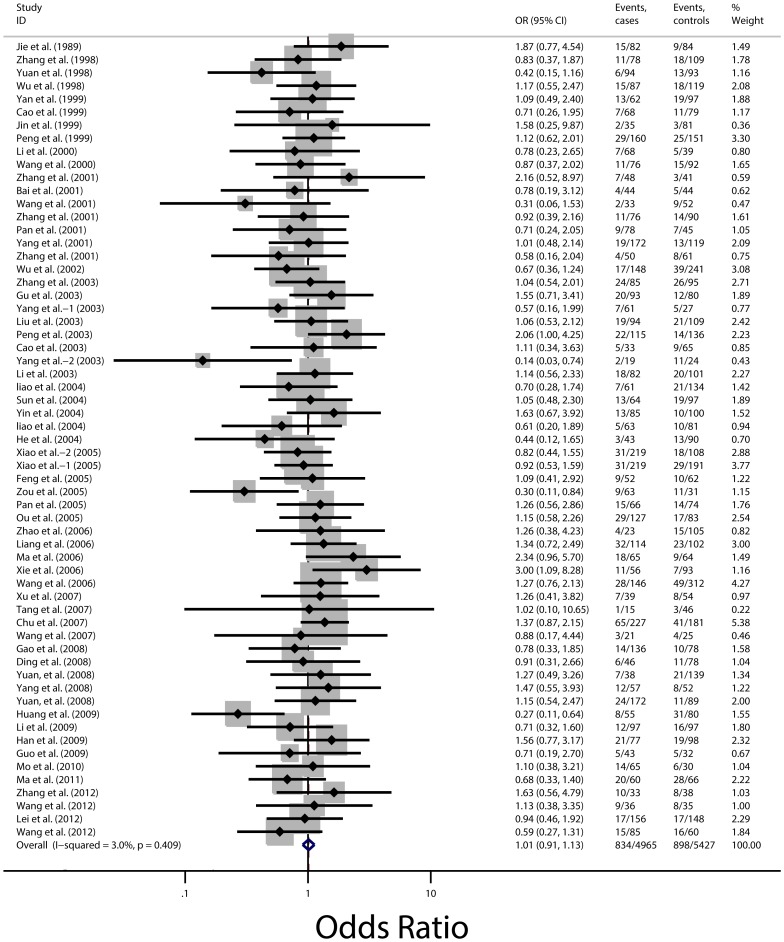
Odds ratios for coronary heart disease in ε2 carriers versus population with the ε3/3 genotype of all 61 studies.Size of the squares is proportional to the weight of the odds ratios; black circular dots indicate the odds ratios; horizontal lines represent the 95% CI. Dark hollow diamonds show the pooled estimates from the random-effects models (with 95% CI) and the fixed-effects model (with 95% CI).